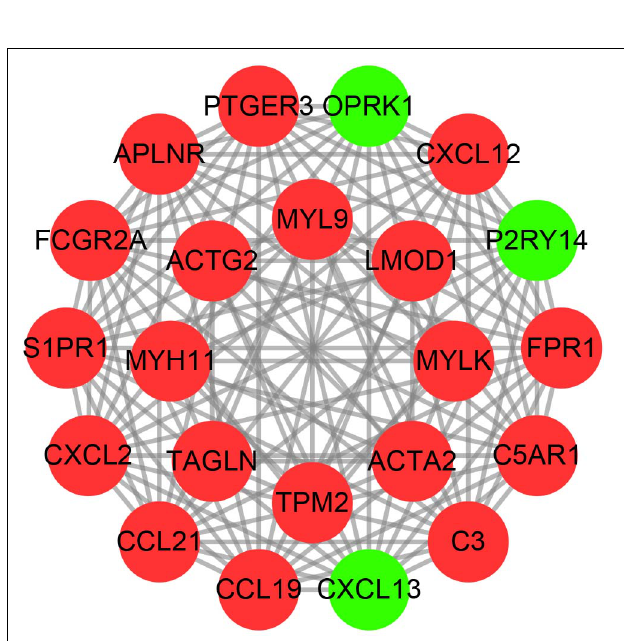
FIGURE 3 | Gene ontology and KEGG enrichment analysis results of the DEGs are shown in panels (A,B) .